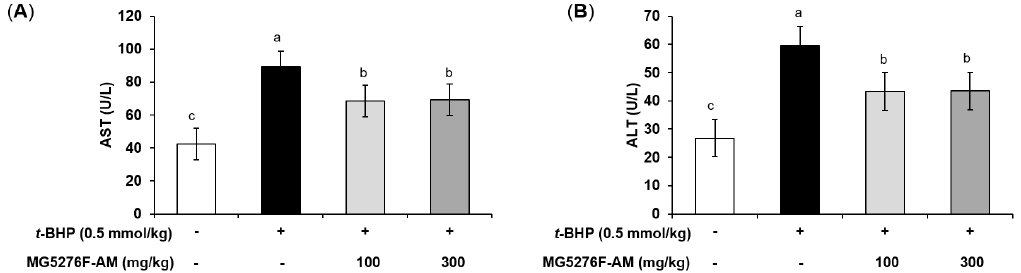
Figure 4. The serum AST ( A ), and ALT ( B ) levels of MG5276F-AM (100 and 300 mg/kg) in t -BHP injected mice. Values are presented as mean ± SEM ( n = 7). Means with the different letters indicate significantly differences determined by Duncan’s multiple range tests ( p < 0.05).